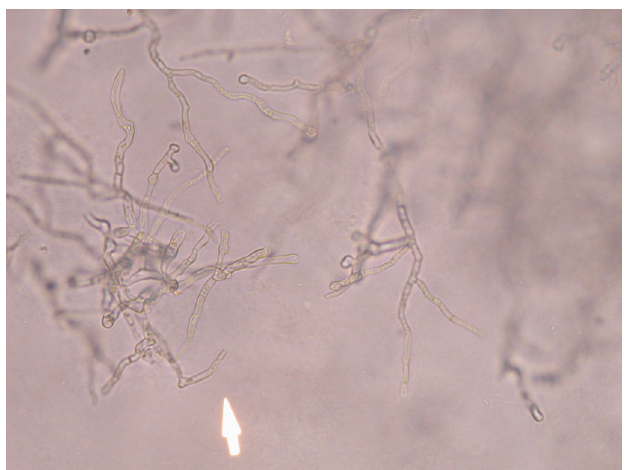
FIGURE 4. Culture on Sabouraud’s dextrose agar at 25°C. B. dermatitidis growing in a mycelial form as a fluffy white mold. The branching hyphae are 2 to 3 µ m in diameter and have right-angled conidiophores that have a single terminal